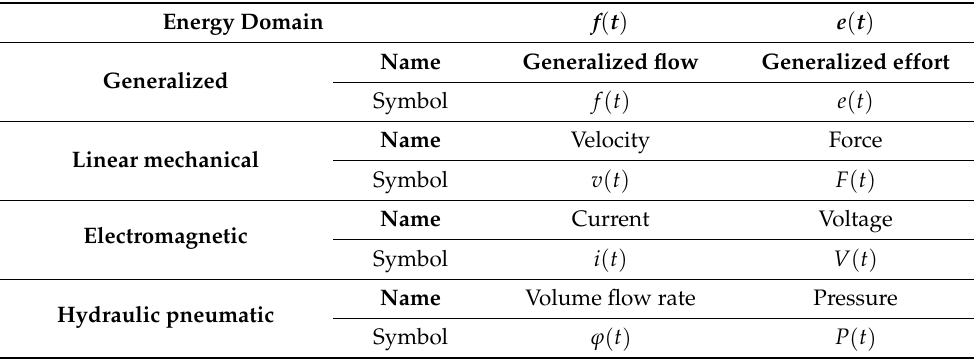
Table 1. Define flow and effect variables in different